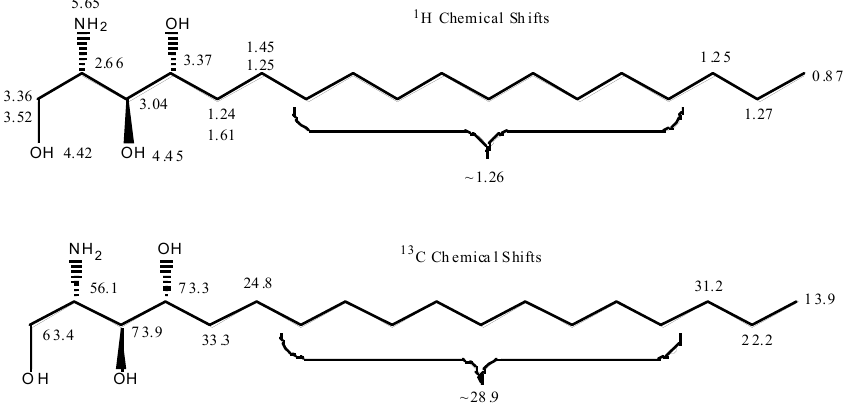
Figure 1. Standard monoelectrospray ionization mass spectrum of phytosphingosine. Increased nozzle/skimmer potentials yield neutral water loss.